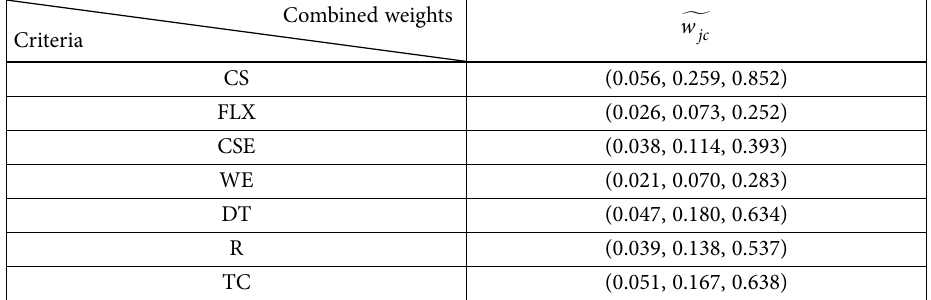
Table 11. The combined weights of the criteria